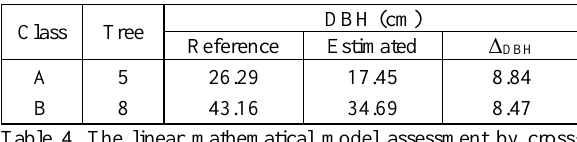
Table 4. The linear mathematical model assessment by cross- validation for class A and class